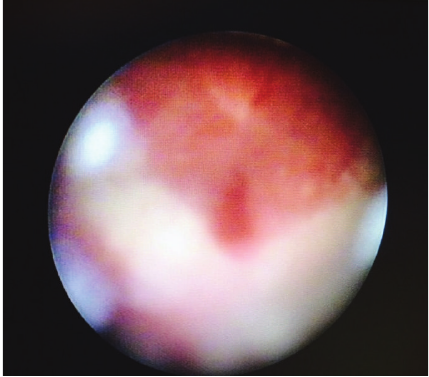
Figure 3: Cystoscopy view of fistula focus on posterior bladder wall.